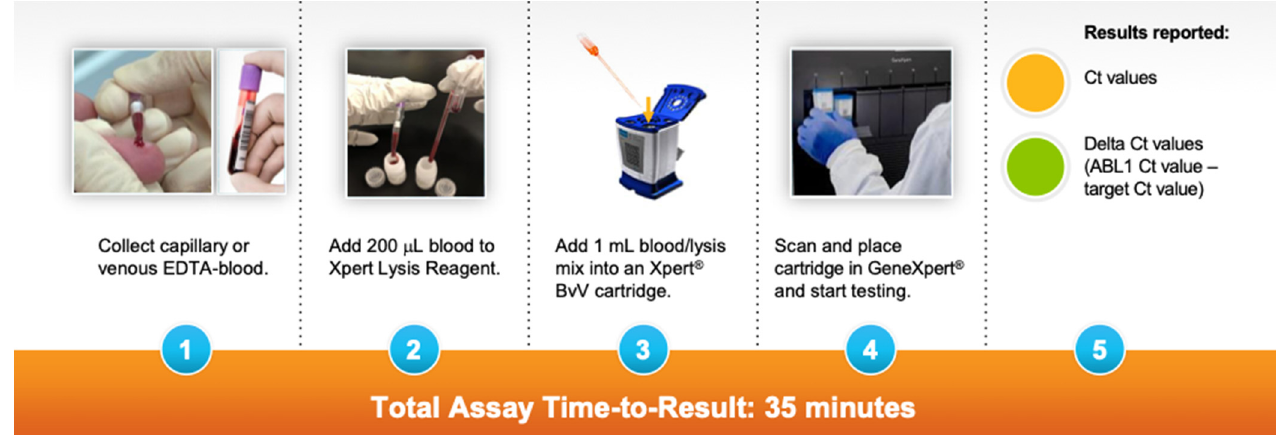
Figure 1. Steps for running the prototype GeneXpert